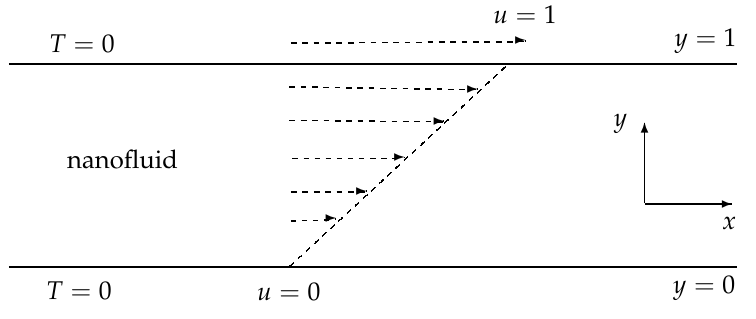
Figure 1. Geometry of the model problem.